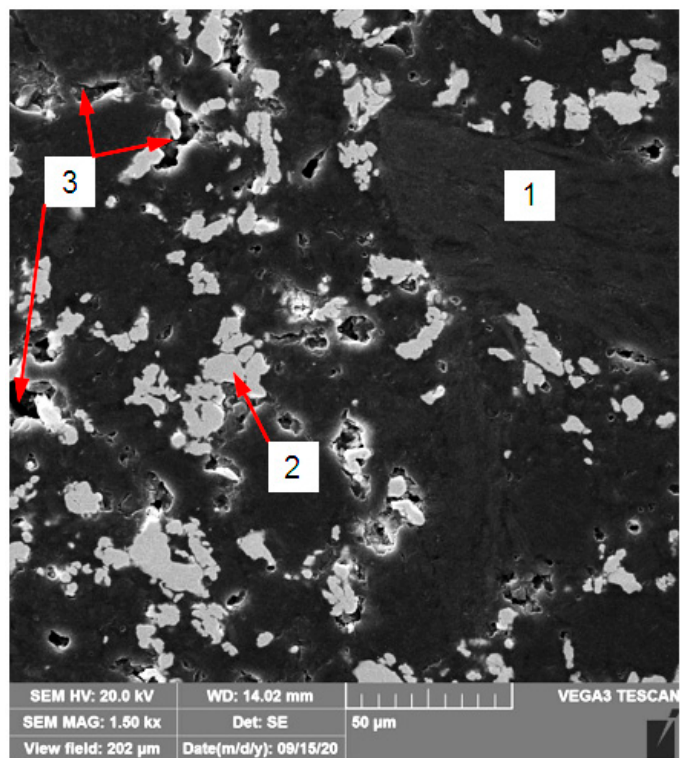
Figure 2. Graphite composite microstructure: 1—graphite matrix; 2—Cu powder (reinforcement); 3— pores.